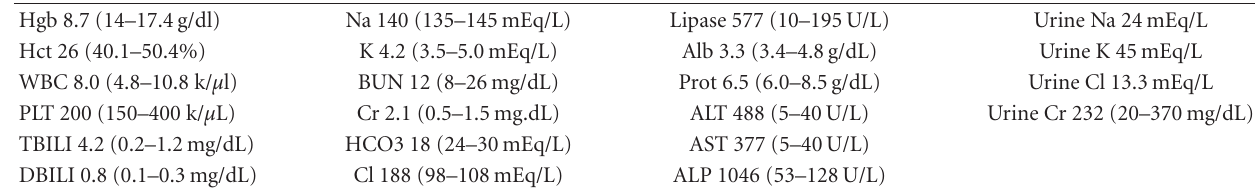
Table 2: Admission laboratory results from second hospitalization (normal values in parentheses).